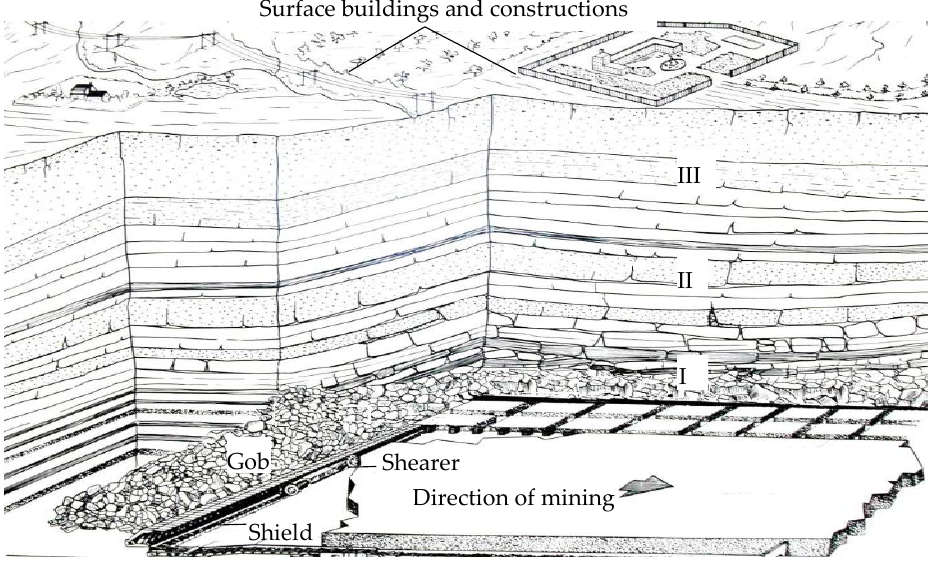
Figure 1. Cut-away view of a longwall panel showing equipment layout and overburden movement, I—caved zone ; II—fractured zone; III —continuous deformation zone.